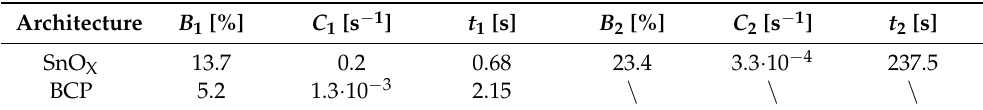
Table 4. Fill ‐ factor fitting parameters. Table 4. Fill-factor fitting